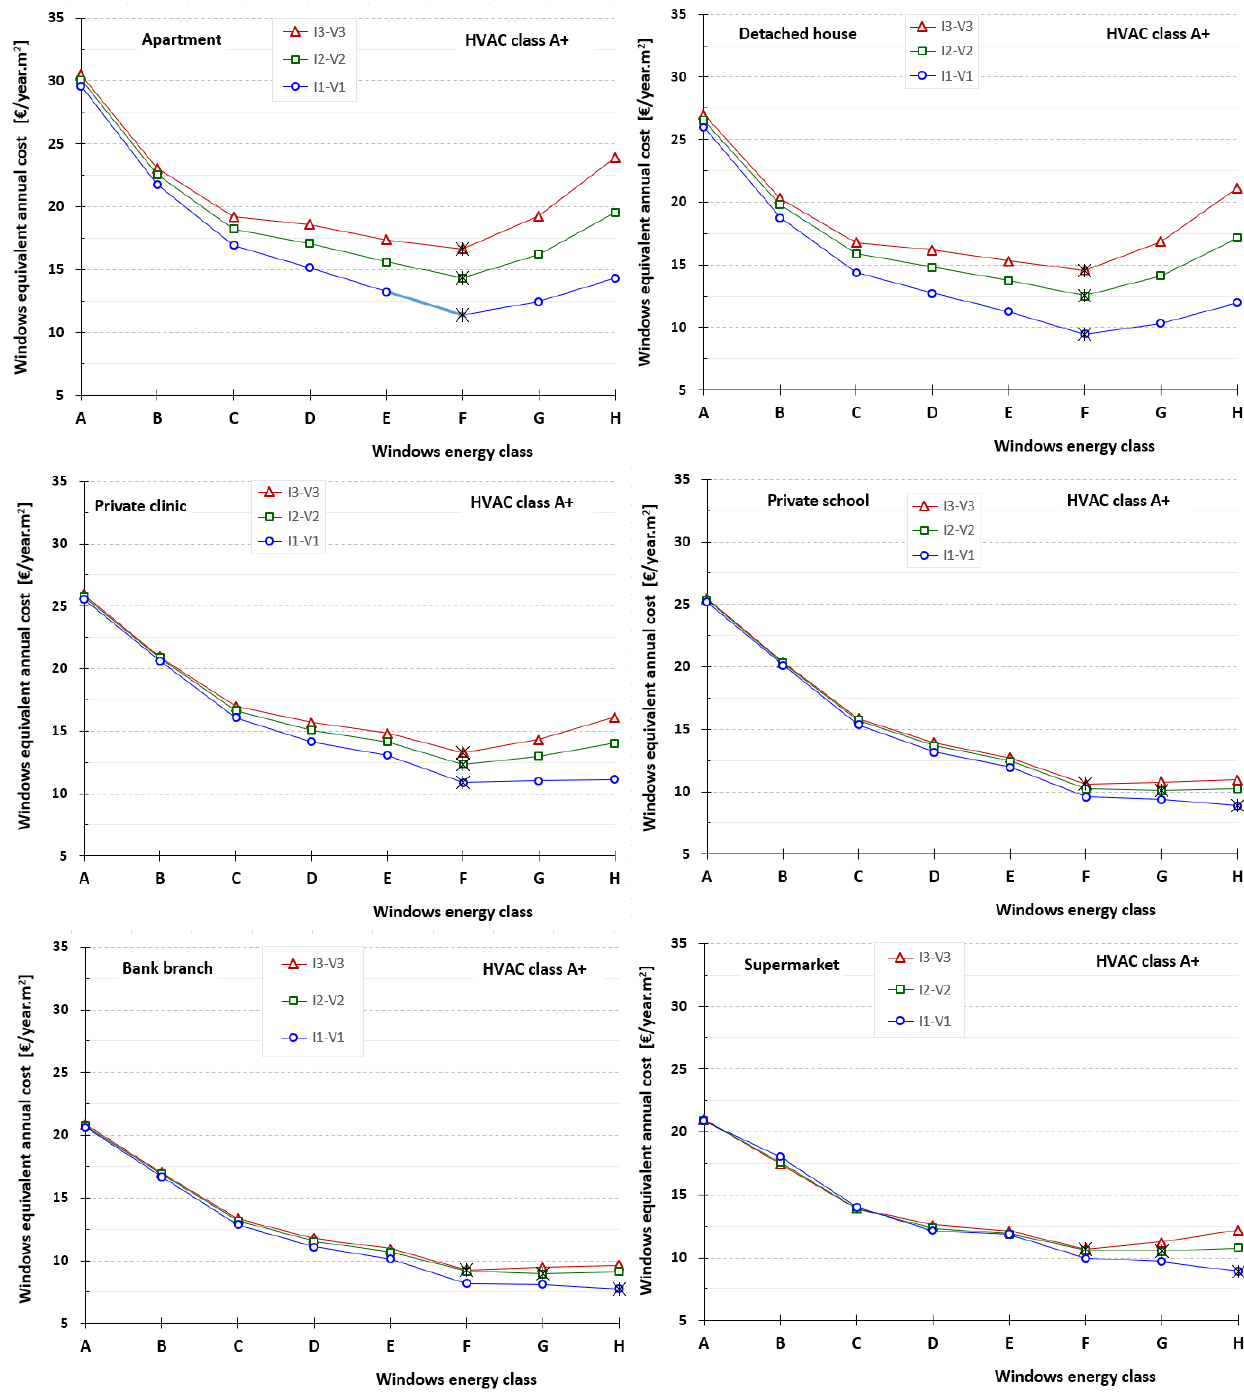
Figure 3. Windows equivalent annual cost ( EAC w ), for each building type, varying according to each climate zone (values per m 2 of glazed area of external envelope).